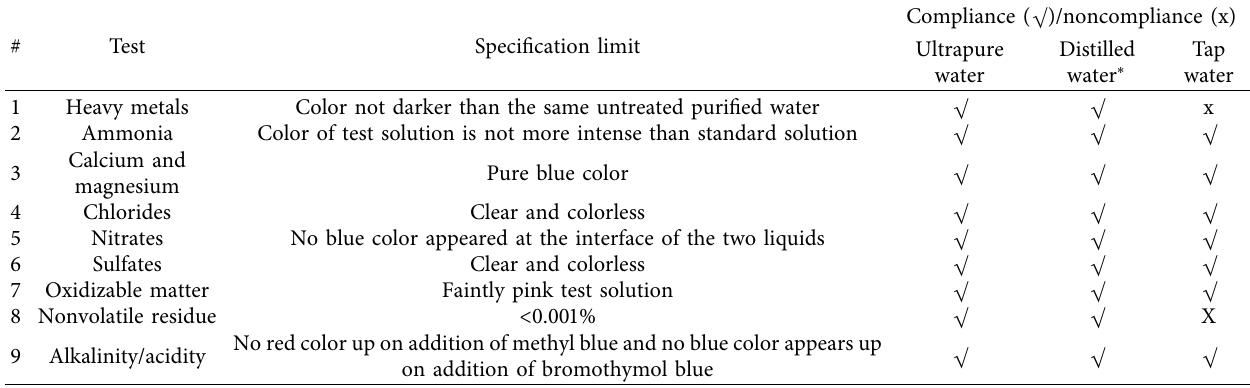
Table 3: Typical analytical quality results of water R according to Ph.